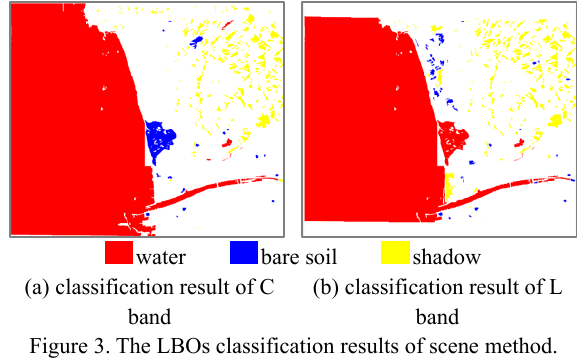
Figure 3. The LBOs classification results of scene